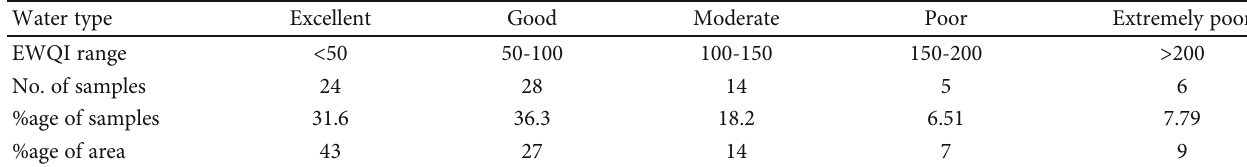
Figure 5: Piper plot for groundwater facies classi fi cation. Table 3: Classi fi cation of the groundwater samples according to